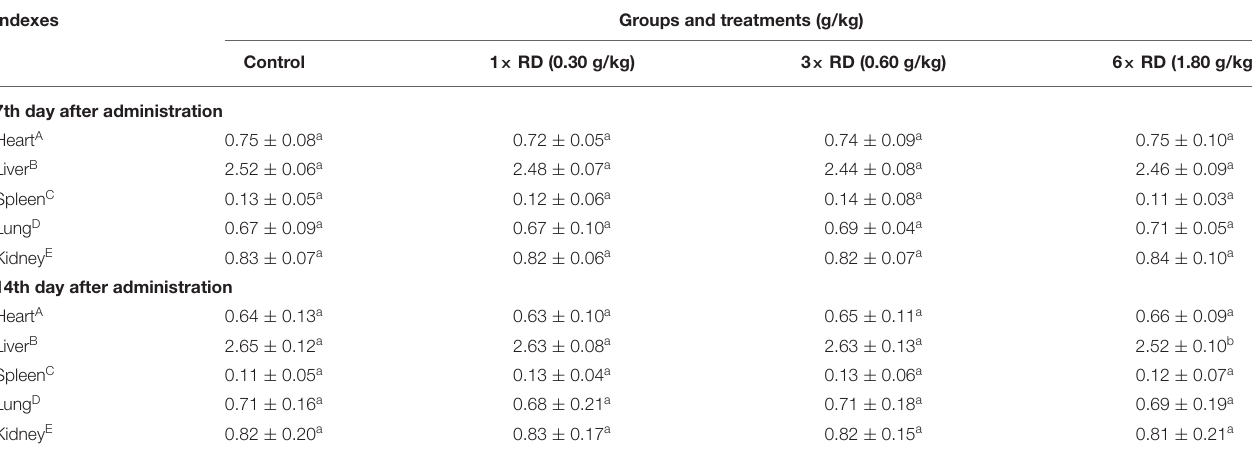
TABLE 4 | Effect of Qinghao Powder on the relative organ weight (ROW) of chicks in the safety test ( n = 10).